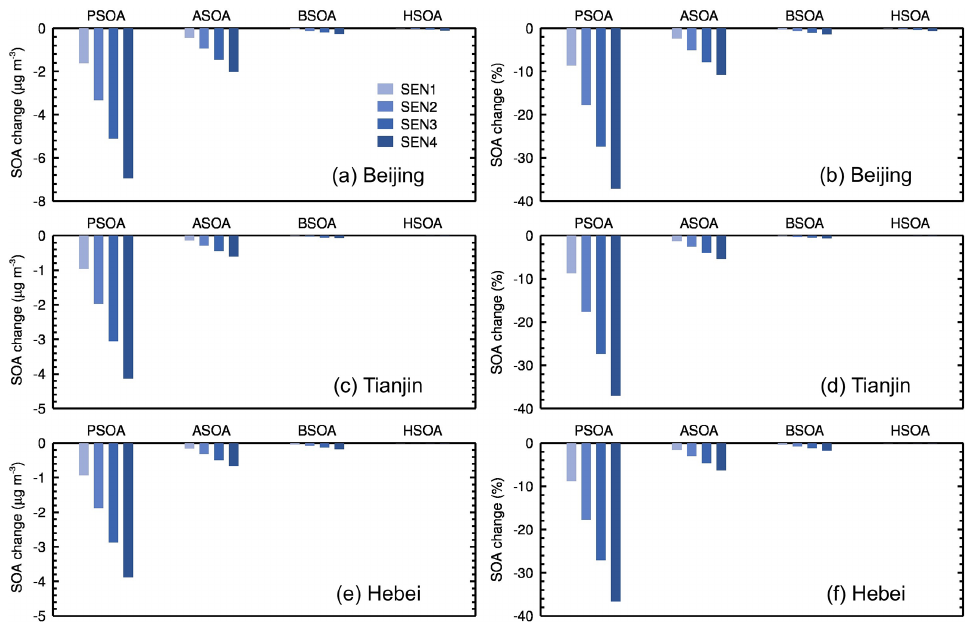
Figure 12. Histogram showing the decreases of SOA from various pathways in (a, b) Beijing, (c, d) Tianjin, and (e, f) Hebei in the sensitivity experiments compared to the REF simulation (SENx–REF; x = 1, 2, 3, and 4). PSOA represents oxidation and partitioning of semivolatile POA and co-emitted IVOCs, ASOA represents oxidation and partitioning of anthropogenic VOCs, BSOA represents oxidation and partition- ing of biogenic VOCs, and HSOA represents heterogeneous reactions of glyoxal and methylglyoxal on aerosol